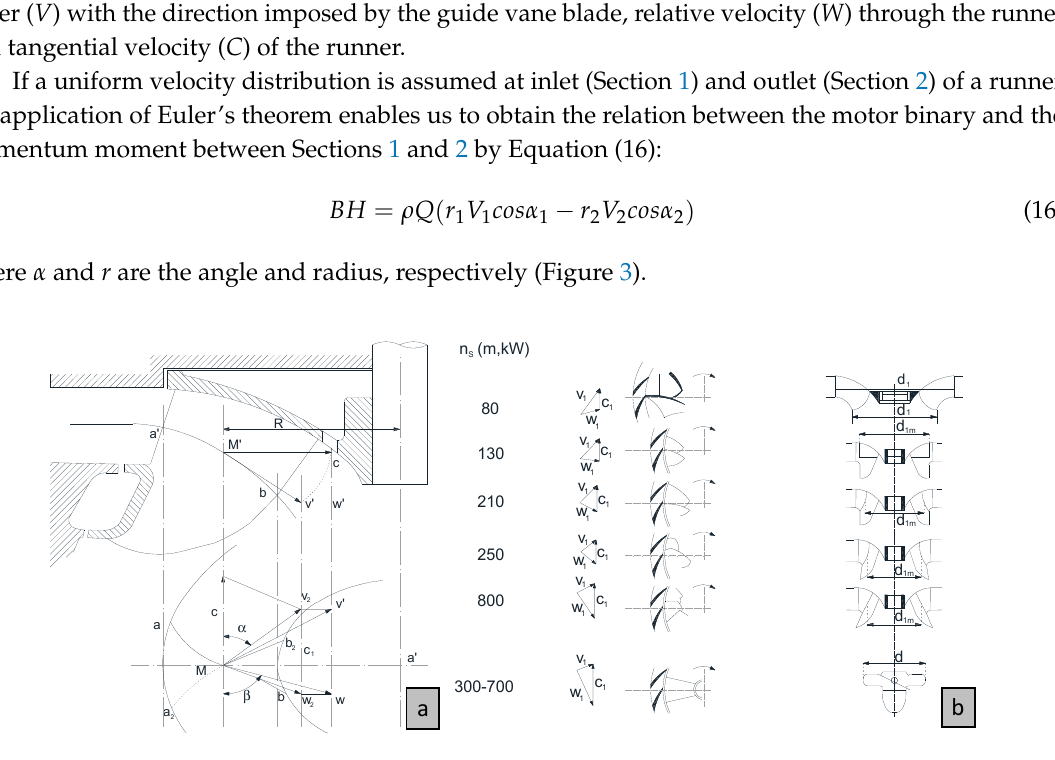
Figure 3. Velocity components across a reaction turbine runner. ( a ) scheme of an impeller and ( b ) velocity vectors (adapted from [6,35,44-50]). The output power in the shaft is defined by Equation (17).